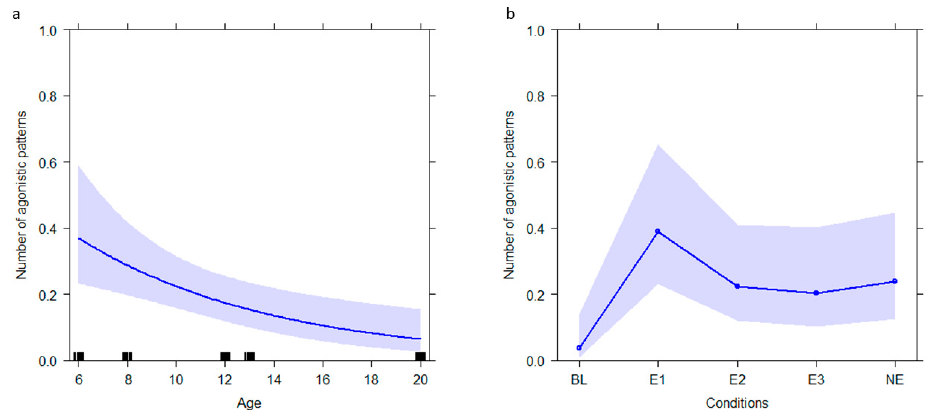
Figure 5. Effect plot of variables having a significant influence on the number of agonistic pat- terns. The number of agonistic patterns ( Y axis): ( a ) decreases as the age of individuals ( X axis) increases, ( b ) varies according to the enrichment condition ( X axis). The band represents the confi- dence interval. Table 4. Full results of the Tukey test for the agonistic behaviors. Significant results are reported in bold. The full model for explorative and scent ‐ marking behavioral patterns (GLM 6 ) was found to be different from the null model (likelihood ratio test: χ 2 = 41.522, df = 16, p < 0.001; Nagelkerke’s pseudo R squared = 0.18). Ambient temperature was found to be a signifi ‐ cant predictor of the target variable (ambient temperature, p = 0.009). (Table3; Figure 6). The analysis showed a trend of significance for the interaction between condition and NDS ( p = 0.072).